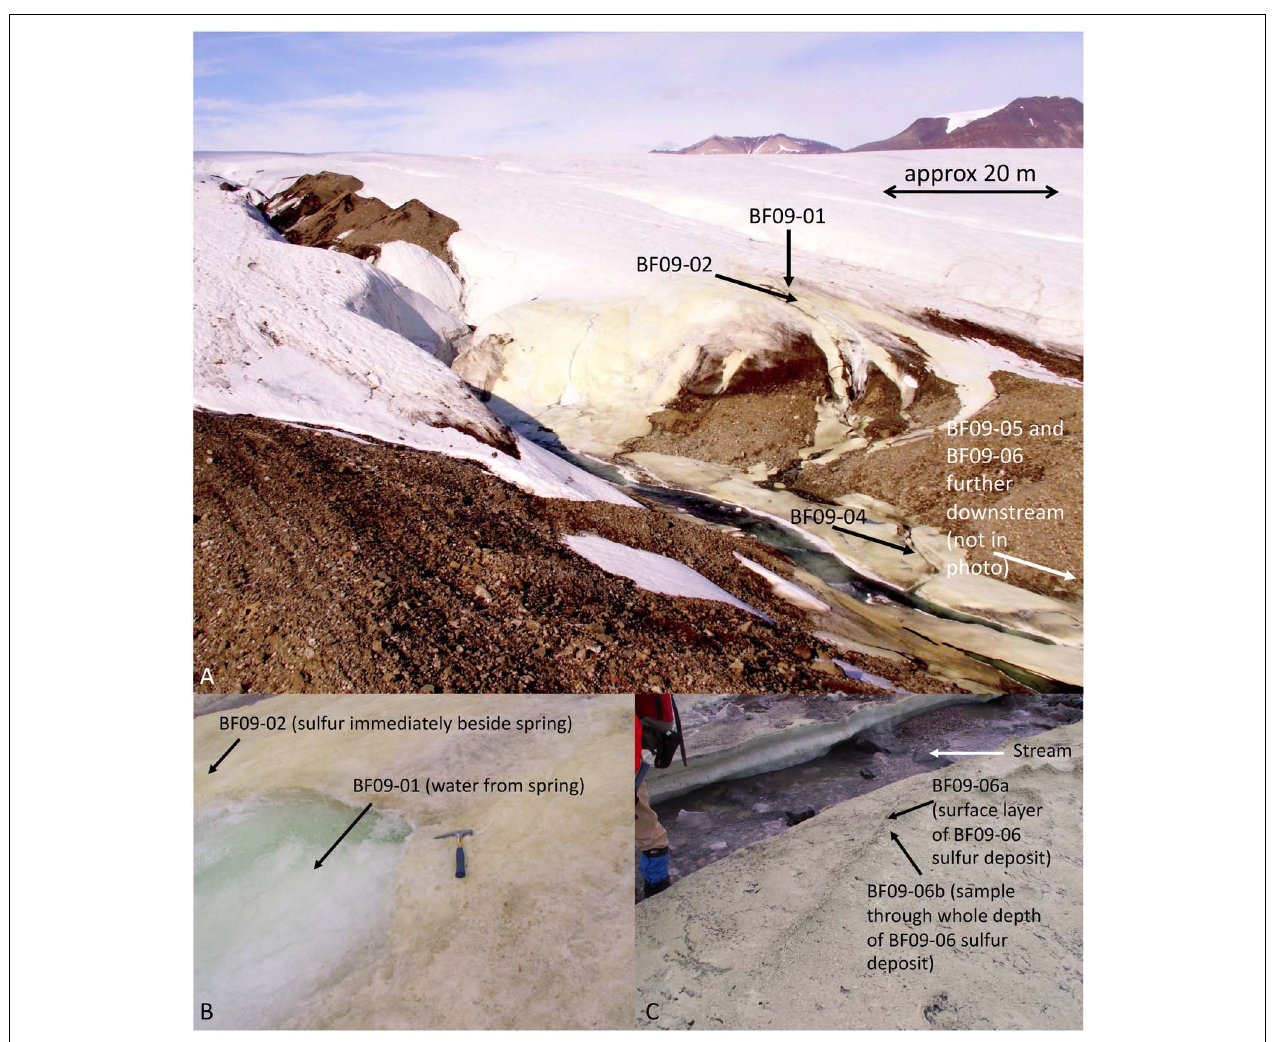
FIGURE 1 | Borup Fiord Pass Glacier. (A) Overview of the field site in 2009. (B) The spring source (site BF09-01) and sulfur varnish beside the spring (site BF09-02). (C) Sulfur deposit BF09-06 from which DNA was extracted for the metagenome.